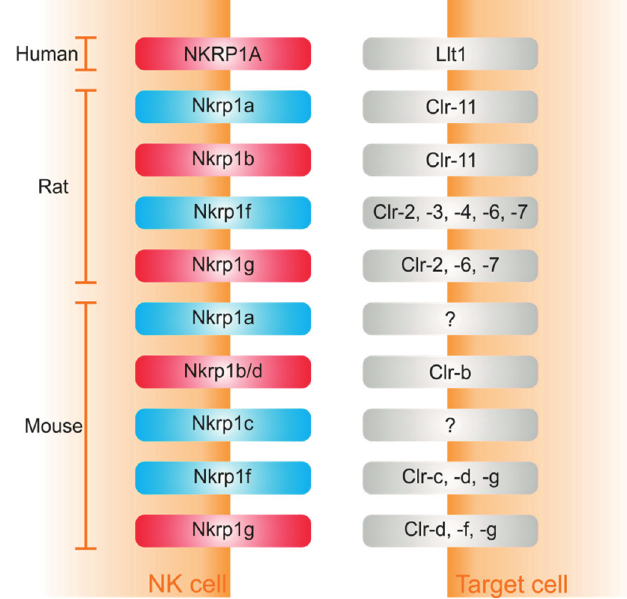
Figure 2. Human, rat and mouse Nkrp1-Clr interactions showing the combinatorial nature of the Nkrp1 repertoire. Inhibitory receptors are in red; activating in